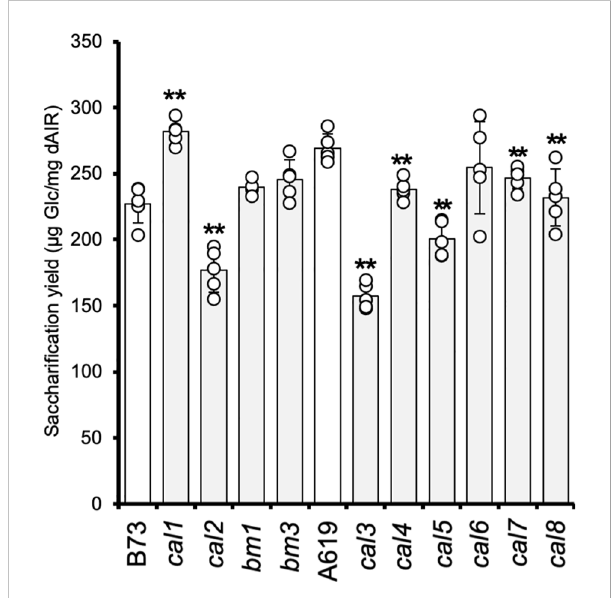
FIGURE 1 Sacchari fi cation of cal mutant seedlings. The values correspond to the mean ± SD (n = 5). cal1 , cal2 , bm1 , and bm3 are in the B73 genetic background. cal3 , cal4 , cal5 , cal6 , cal7 , and cal8 are in the A619 genetic background. dAIR destarched alcohol insoluble residue. Asterisks indicate levels of statistical signi fi cance between each mutant and corresponding wild-type plant determined by two- tailed unpaired Student t - test at p -value < 0.01